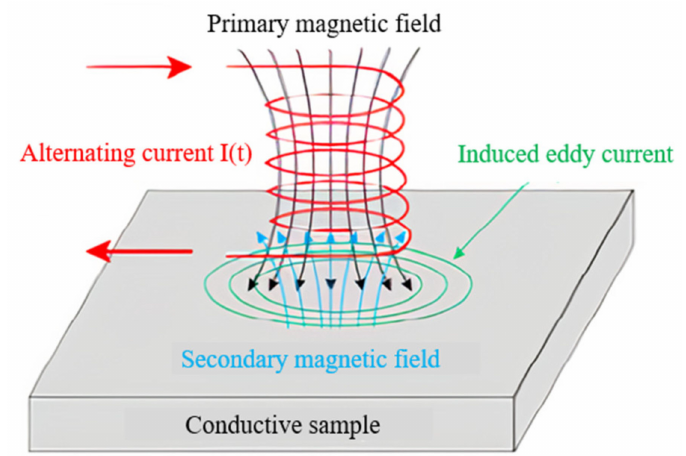
Figure 3. Induced currents in conductive material